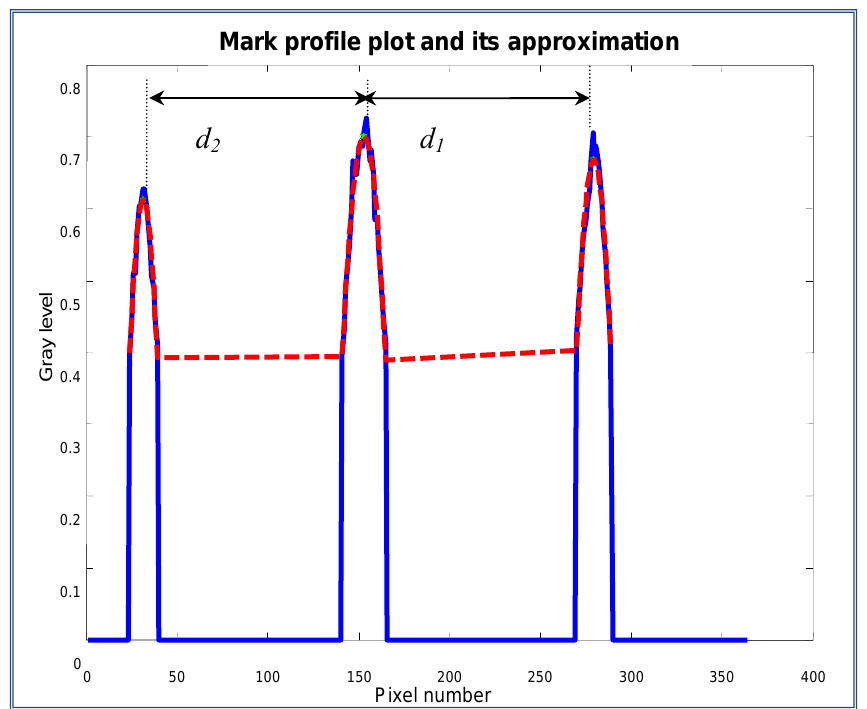
and d , and K 1 2 = d / d = 0.96. meas 2 1